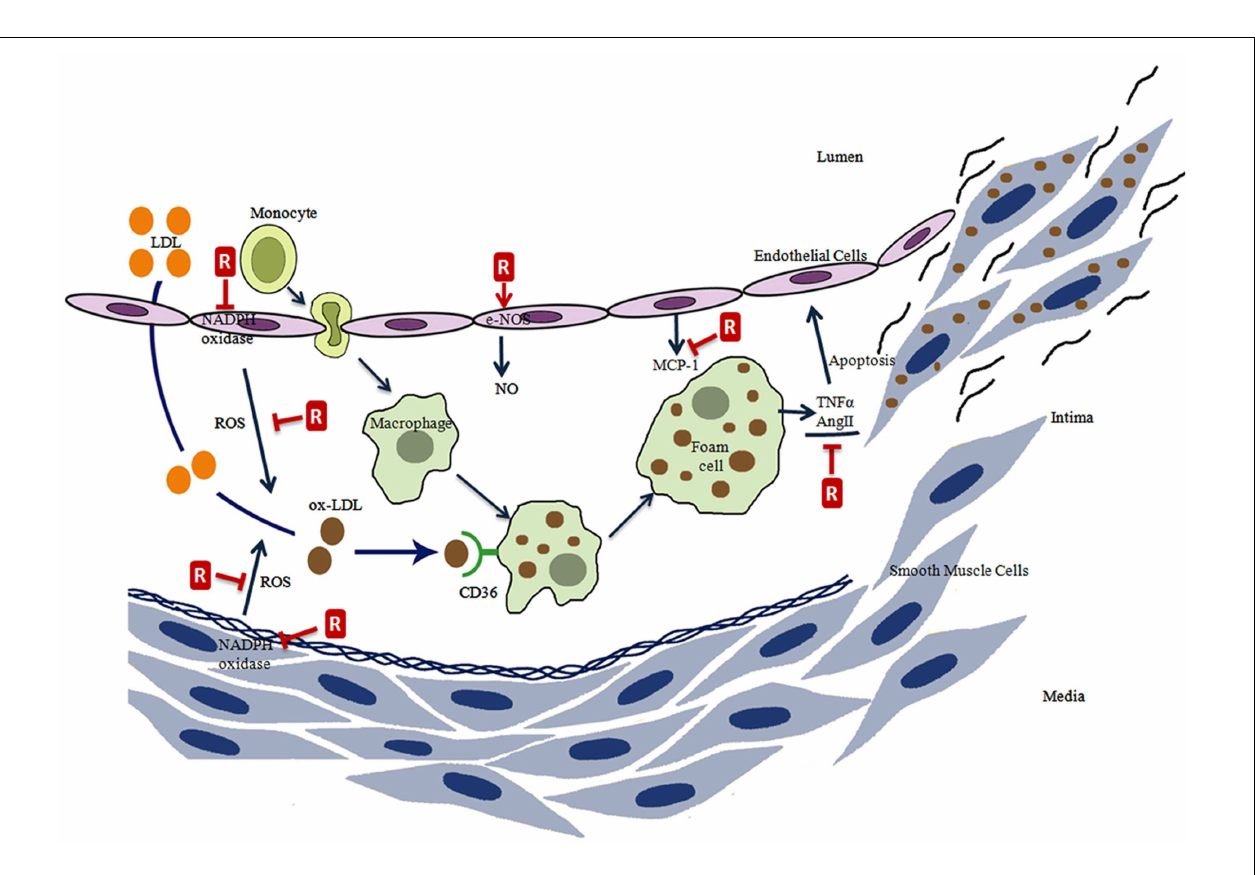
chemoattractant protein-1 (MCP-1) expression, inhibits the tumor necrosis factor alpha (TNF α ), and angiotensin II (AngII) induced endothelial cell